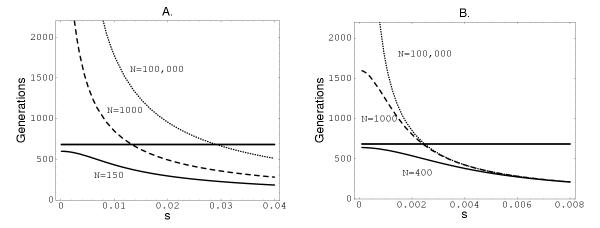
Mean sojourn times as functions of selective coefficient s, for different values of N. Left: from a = 1/N to b = 1 - 1/N; Right: from a = 0.3 to b = 0.7.